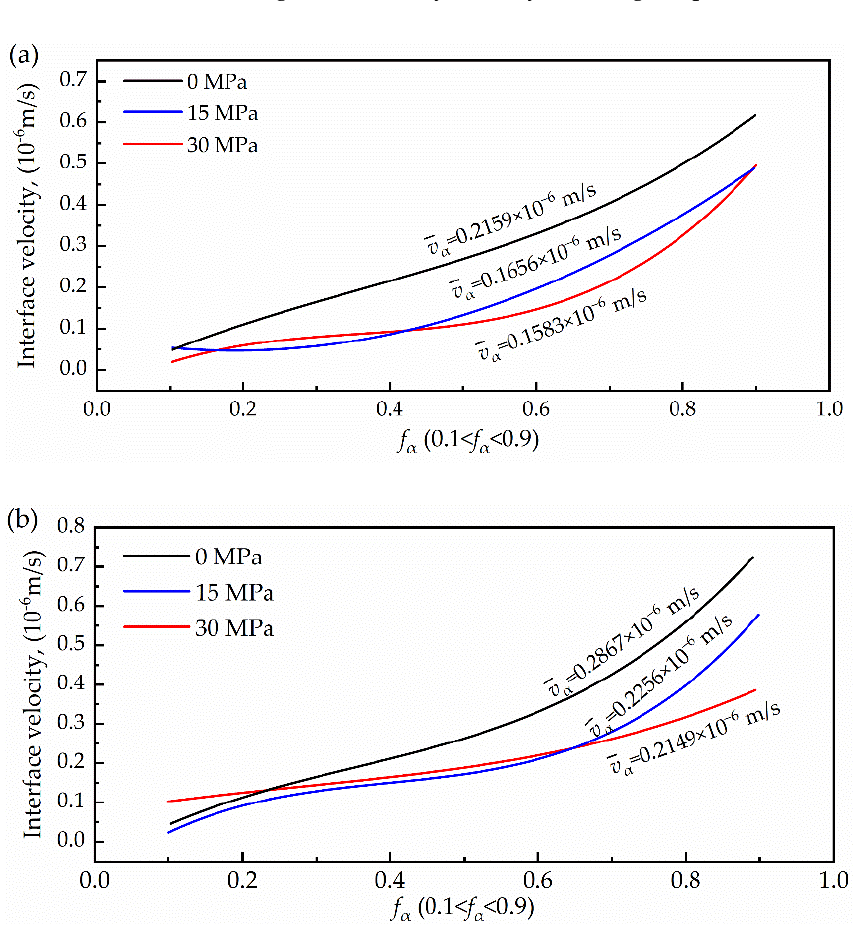
Figure 8. The interface migration velocity as determined for the indicated applied compressive stress. ( a ) 25 K/min; ( b ) 50